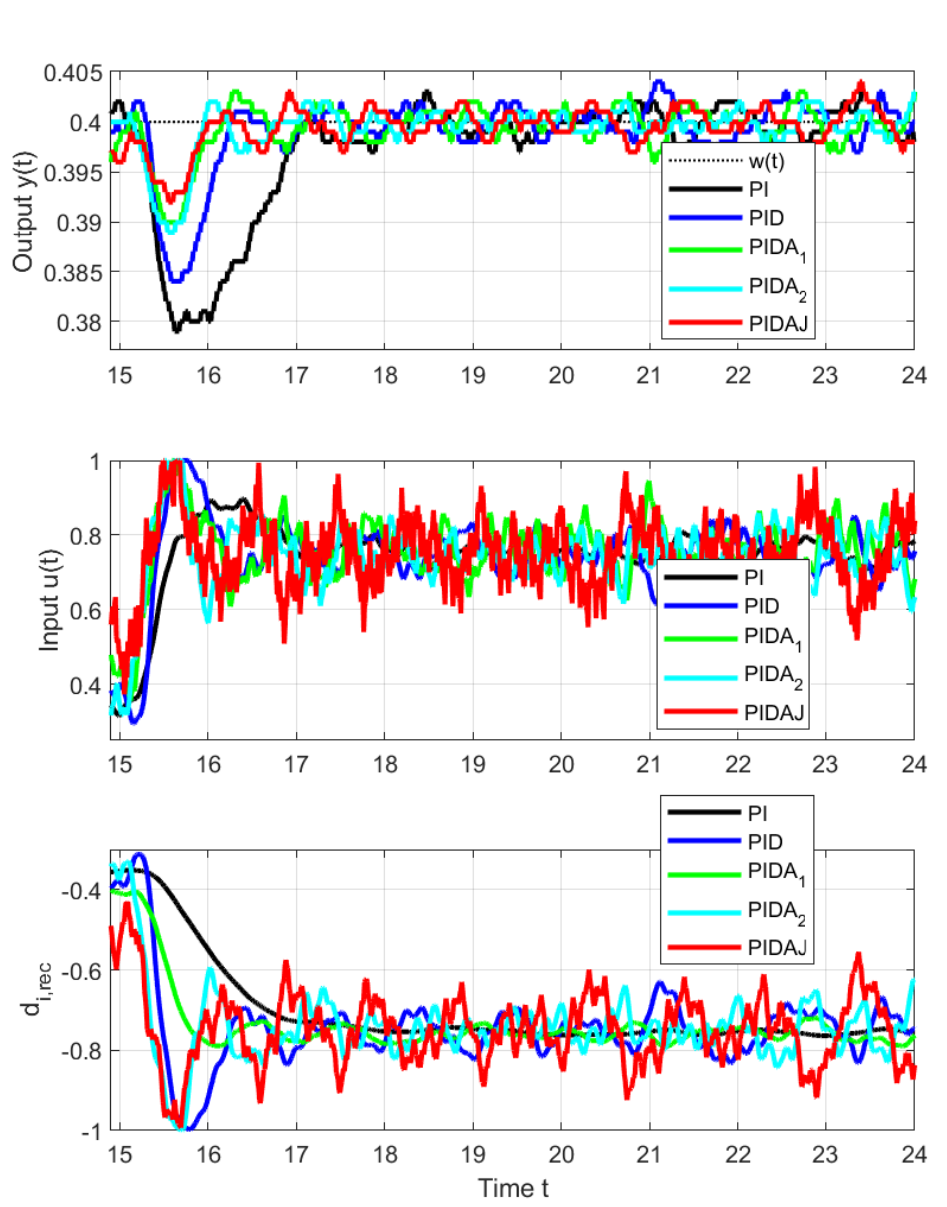
Figure 7. Details of load disturbance step responses from ∆ u = 0 to ∆ u = 0.5 at t = 15